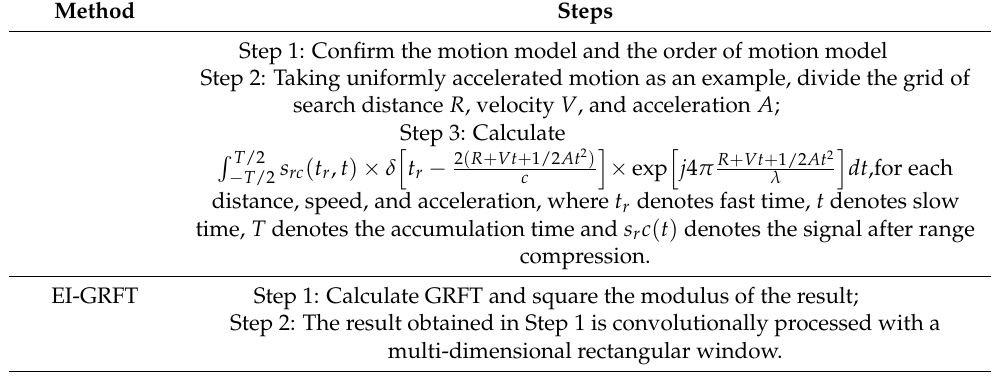
Table 3. Summarization of the steps for different